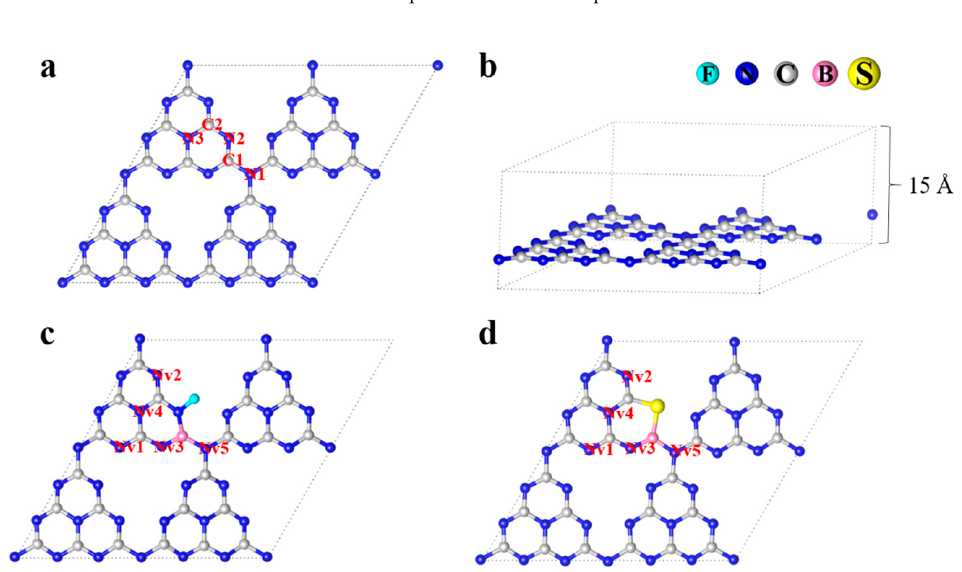
Figure 1. Pristine and doped g-C 3 N 4 geometries. ( a ) Top view of pristine g-C 3 N 4 geometry. ( b ) Side view of pristine g-C 3 N 4 geometry. ( c ) N v sites of B-F-N v . ( d ) N v sites of B-S-N v